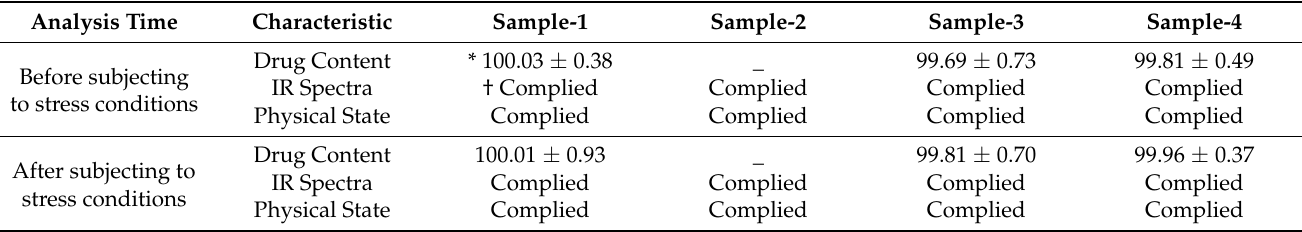
Table 3. Results of drug excipient compatibility